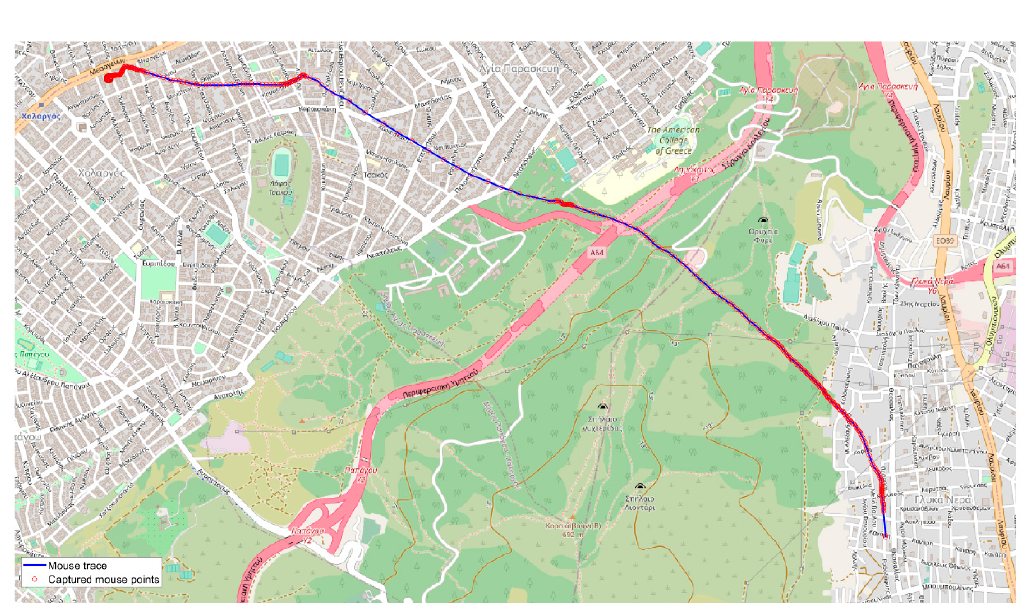
Figure 3. Visualization of the generated mouse trajectory during visual search on experimental stimulus: Mouse trace is presented as a continuous blue line while captured mouse points are highlighted with red circles.